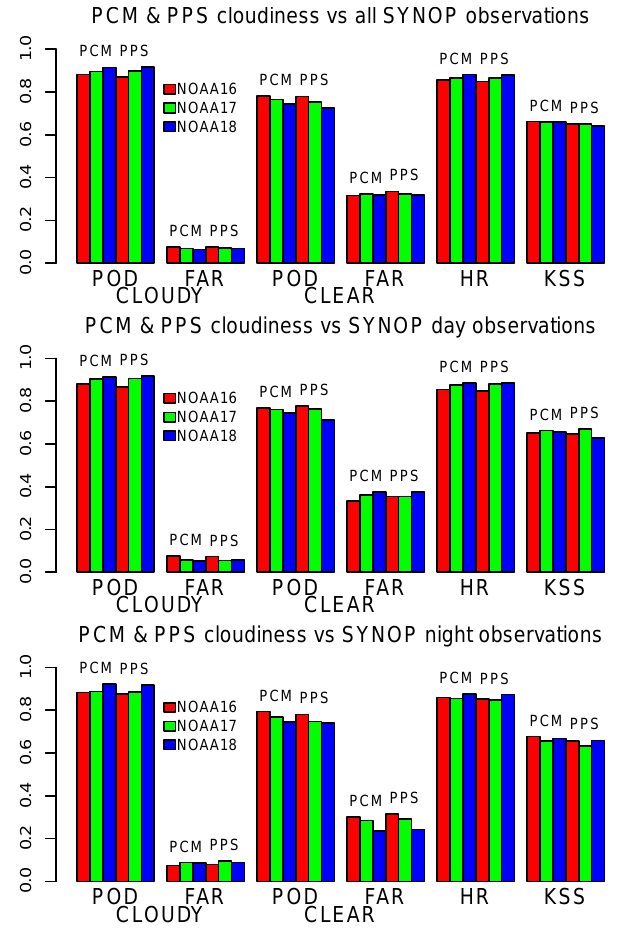
Fig. 18. Accuracy indicators of the PCM and PPS cloud detection skills derived from the comparison with CALIOP vertical feature mask. For details see Sect.